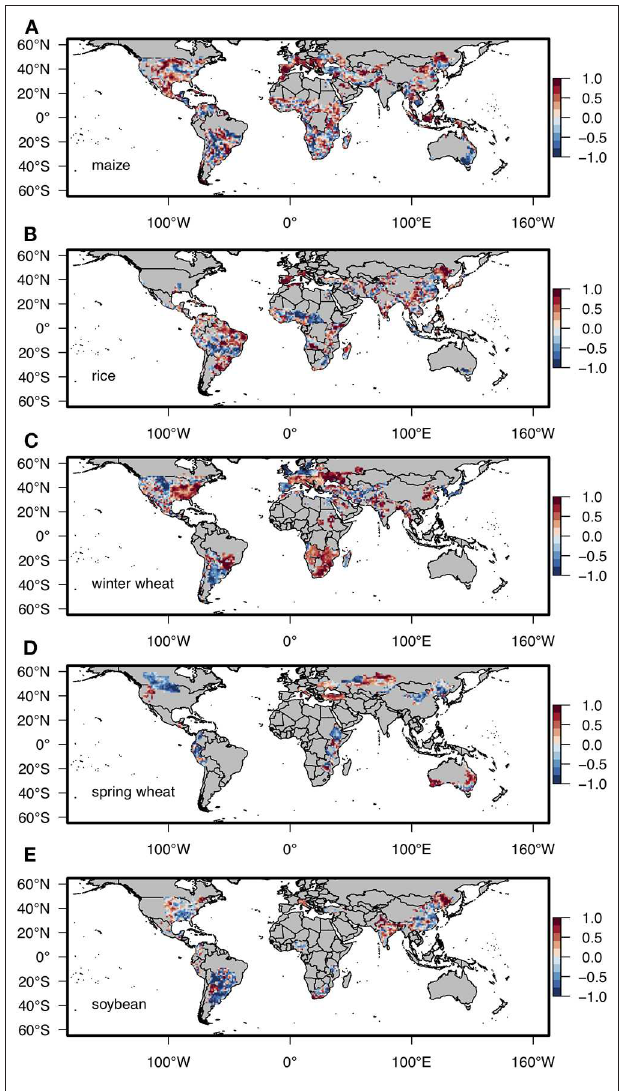
FIGURE 3 | Horizontal distributions of the degree of the contribution of the error due to the seasonal climate prediction to the RMSE (i.e., the difference between the RMSE of the seasonal climate prediction and that of the crop model for each grid) of the predicted yields for (A) maize, (B) rice, (C) winter wheat, (D) spring wheat, and (E) soybean. Class X indicates grids where the RMSE of the predicted yields can be explained by the crop model error. Classes A, B, and C indicate grids where some of the RMSE of the predicted yields can be explained by the prediction error of the seasonal